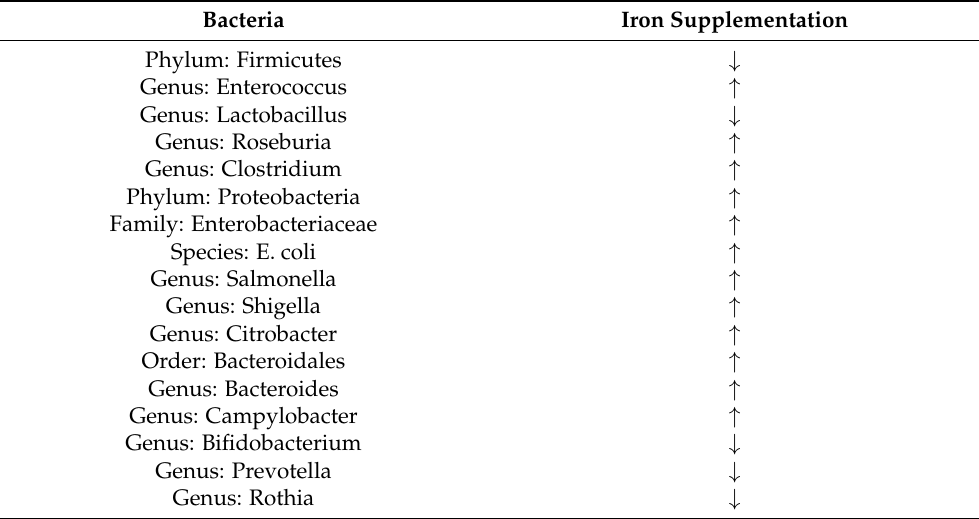
Table 1. Impact of oral iron supplementation on gut microbiota composition ( ↓ —decrease, ↑ —increase).